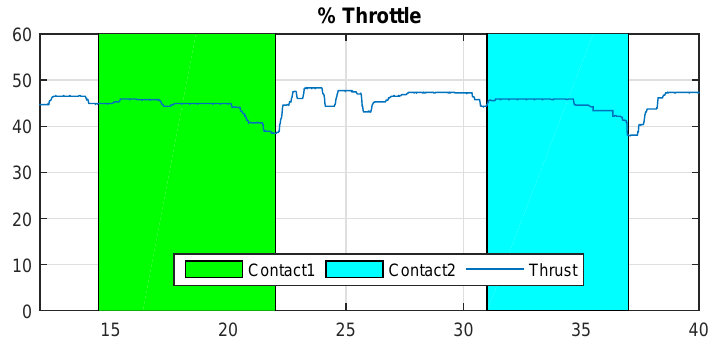
Figure 14. % Throttle—Cartuja bridge